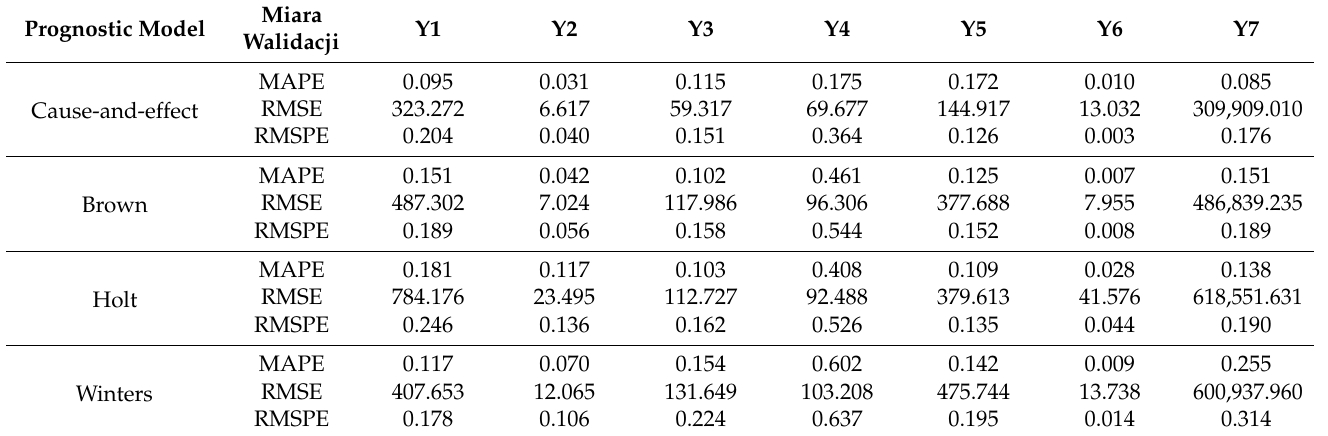
Table 5. Values of the validation measures of forecasting models according to the forecast